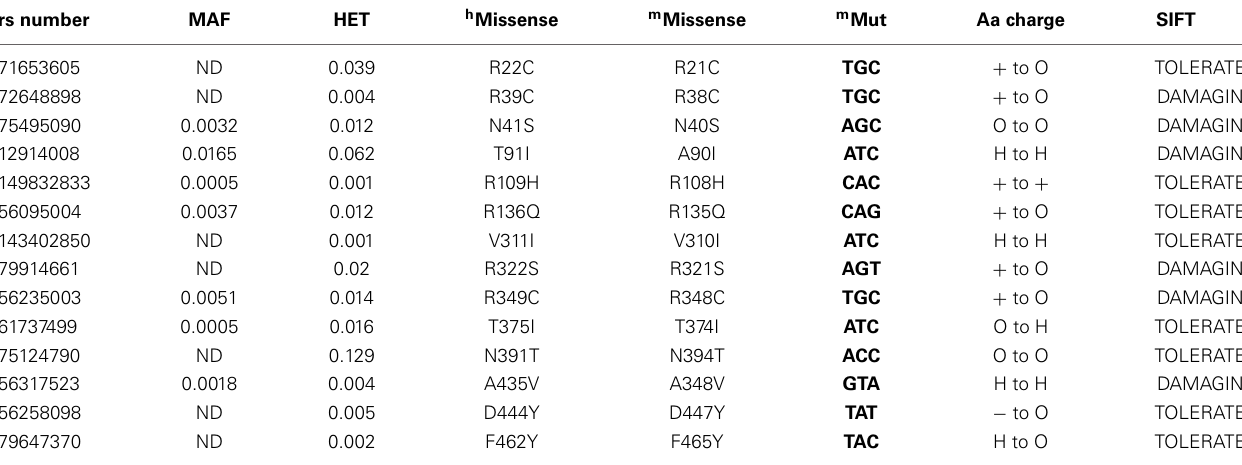
Table 1 | Missense SNPs in CHRNB4 and corresponding variants introduced in the mouse sequence. rs